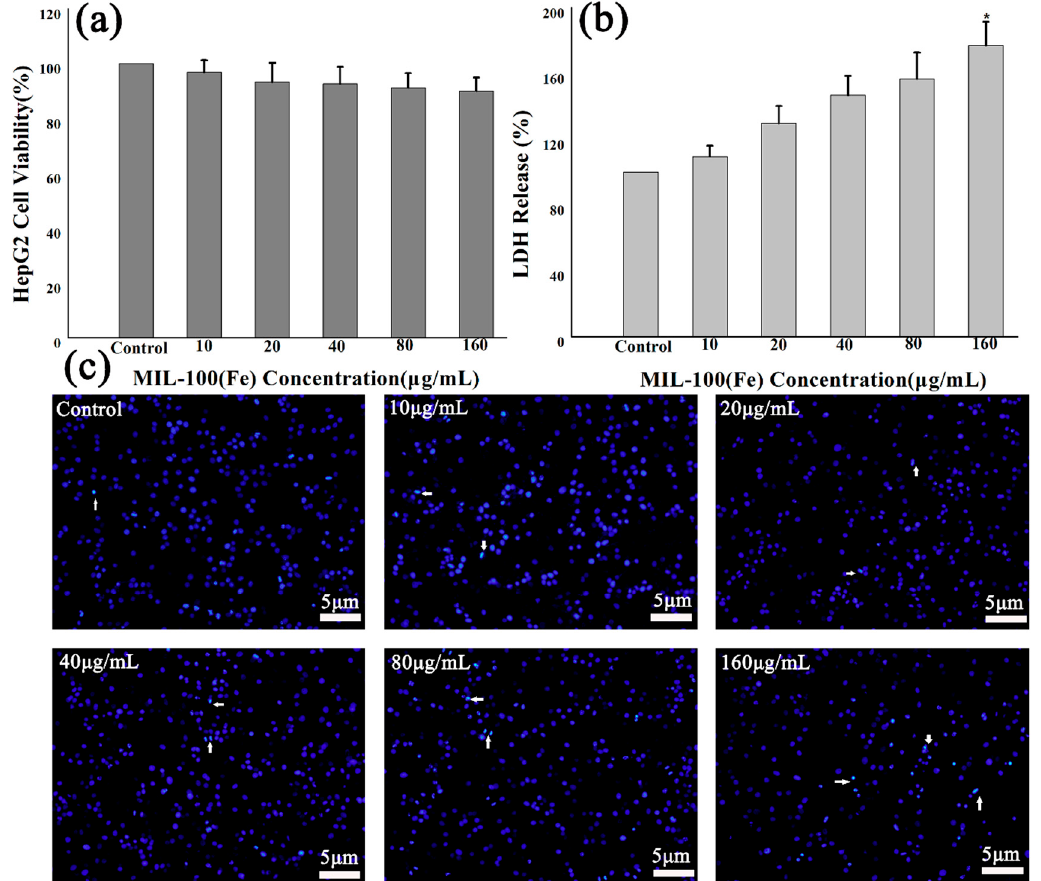
Figure 6. Effects of MIL-100(Fe) on HepG2 cells’ viability, membrane, and morphology: ( a ) In vitro cell viabilities of HepG2 cells after being incubated for 48 h with MIL-100(Fe); ( b ) LDH release of HepG2 cells incubated for 48 h with MIL-100(Fe); ( c ) nuclear morphology images of HepG2 cells after 48 h exposure to MIL-100(Fe). (* p < 0.05 vs. Control.)